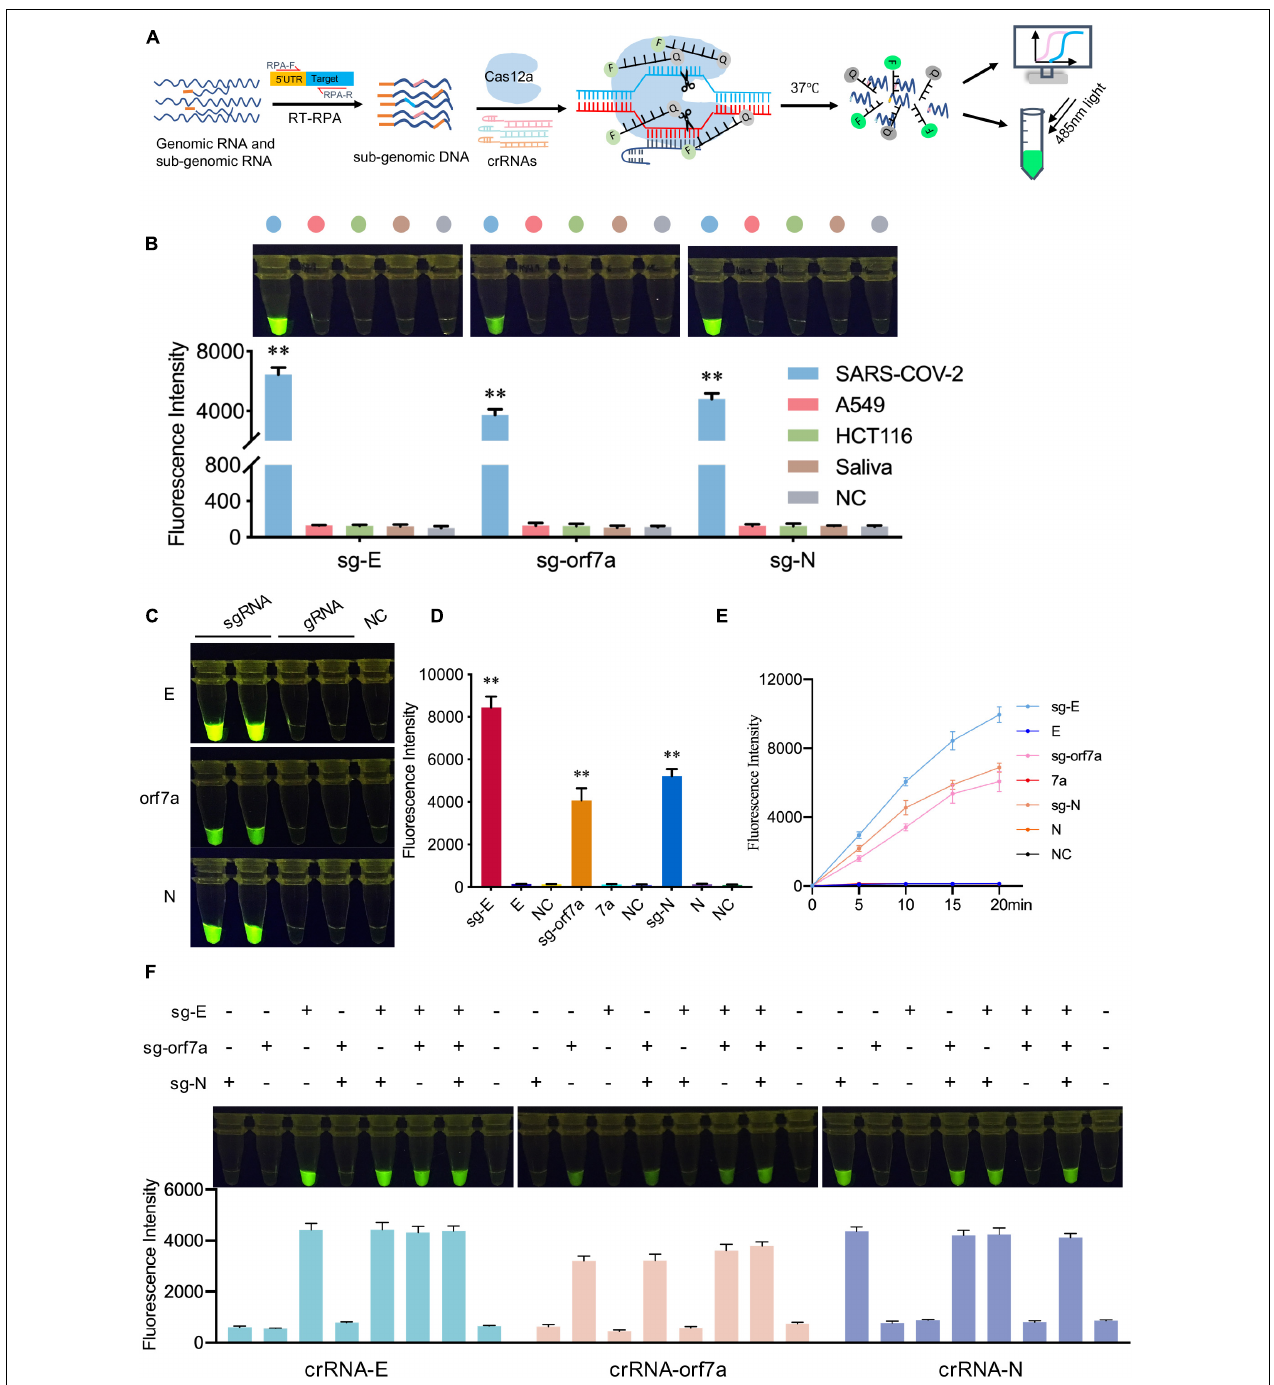
FIGURE 4 | CRISPR-actCoV can detect SARS-CoV-2 sgRNAs with high specificity. (A) Schematic illustration of the specificity assessment workflow. SARS-CoV-2 sgRNAs were amplified by RT-RPA using specific primers and subjected to CRISPR/Cas12a reporter system applied with specific crRNAs and ssDNA reporter. (B) Specificity validation of CRISPR-actCoV by distinguishing SARS-CoV-2 sgRNAs with background nucleic acid from human cell lines (A549, HCT116) or normal human saliva. The fluorescent images and intensities at 15 min of the reaction were shown. (C) Specificity assessment of CRISPR-actCoV by detecting samples containing SARS-CoV-2 sgRNA or gRNA. The fluorescent images at 15 min of the reaction were shown. (D) The fluorescent intensities of data in panel (C) were quantified by ImageJ and visualized with GraphPad. All the error bars were determined from three independent experiments. (E) A time-course assay of SARS-CoV-2 sgRNAs and gRNAs detection. (F) CRISPR-actCoV specificity assessment by detecting cross-reaction between different SARS-CoV-2 sgRNAs. sgRNA of E, orf7a, or N were detected individually or simultaneously in a reaction. The fluorescent images and intensities at 15 min of the reaction were shown. Data were collected from at least three independent experiments and was presented as Mean ± SD. The significance was considered as ** p < 0.01.